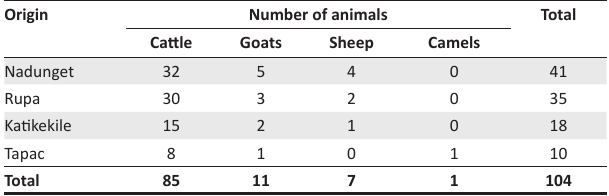
TANZANIACONGO FIGURE 1: Map of Uganda showing one of echinococcal endemic regions (circled pattern) and administrative sub-counties of Moroto district. TABLE 1: Areas of origin and number of animals that were considered for genotyping of Echinoccocus granulosus strains.